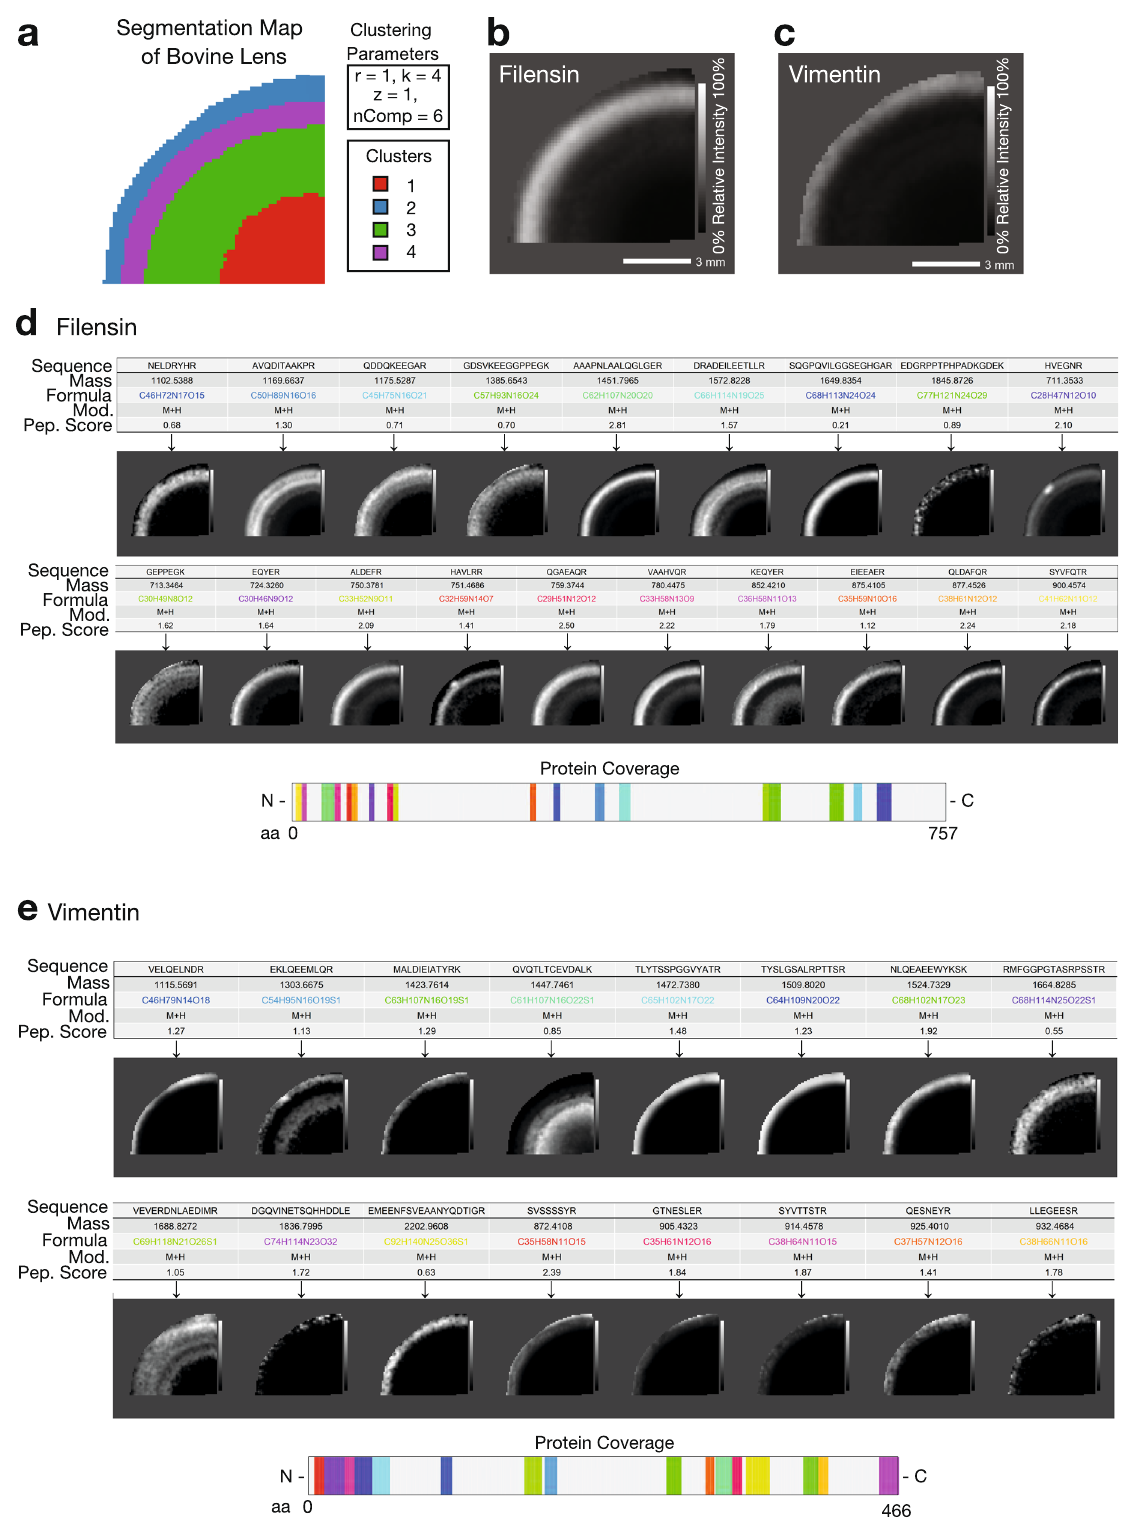
Fig. 5 Application of HIT-MAP to a bovine lens FT-ICR mass spectrometry imaging dataset. a Spatial k -means clustering was performed on the bovine lens into n = 4 unsupervised segments based on prior knowledge of lens biology. b HIT-MAP protein cluster image of Filensin comprising 19 robustly annotated m / z features. c HIT-MAP protein cluster image of Vimentin comprising 16 m / z features. d Individual peptide distributions and protein coverage for Filensin shown in b (scale bar = 3 mm). e Individual peptide distributions and protein coverage for Vimentin shown in c (scale bar = 3 mm). Intensity scales represent relative intensity from 0 to